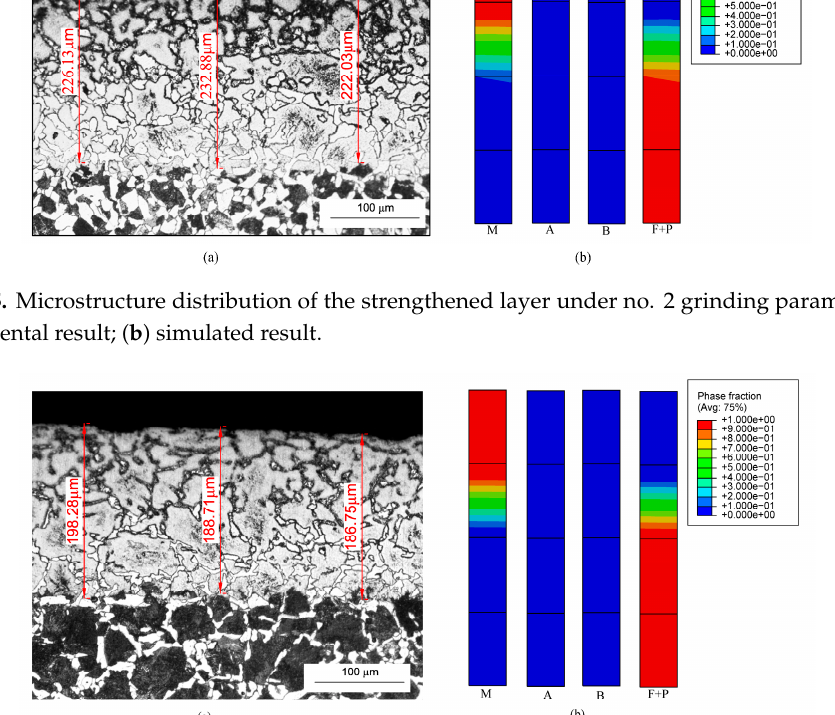
Figure 6. Microstructure of the strengthened layer under no. 3 grinding parameter: ( a ) experimental result; ( b ) simulated result.